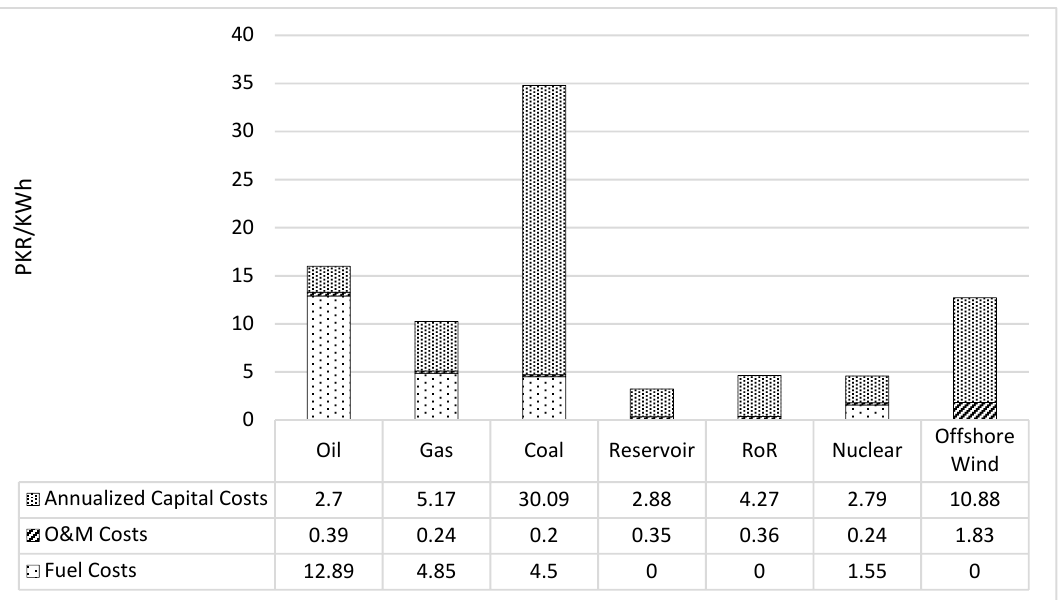
Figure 12. Comparison of electricity costs from different sources.